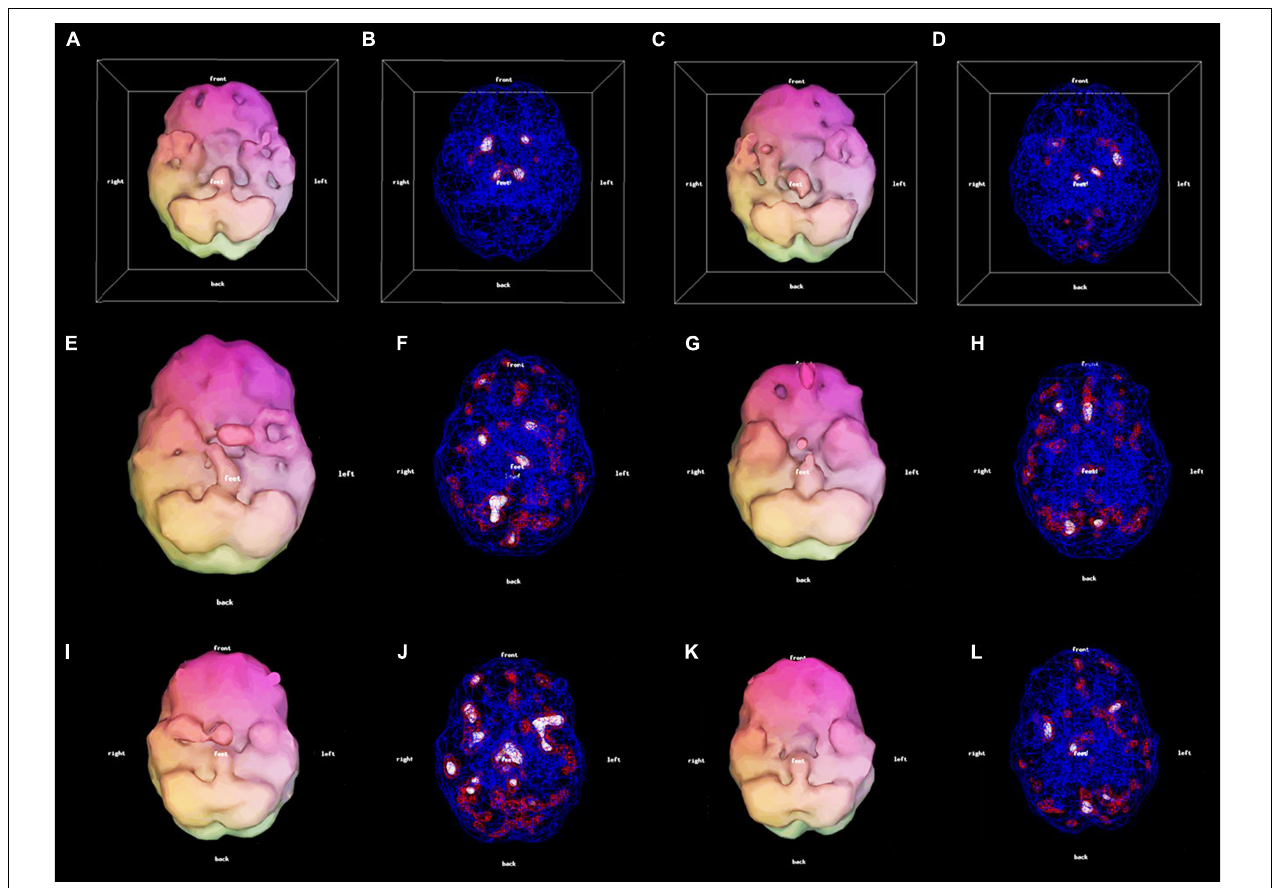
FIGURE 2 | 3D thresholded displays: 56-year-old female with Lyme disease pre-treatment (A,B) and post-treatment (C,D) clinically improved. 33-year-old male with mood dysregulation and ADHD pre-treatment (E,F) and post-treatment (G,H) . There was clinical improvement with a mood stabilizer. However, due to the prefrontal hypoperfusion (G) a stimulant was added resulting in further improvement. 26-year-old female with mTBI pre-treatment (I,J) and post-treatment (K,L) clinically